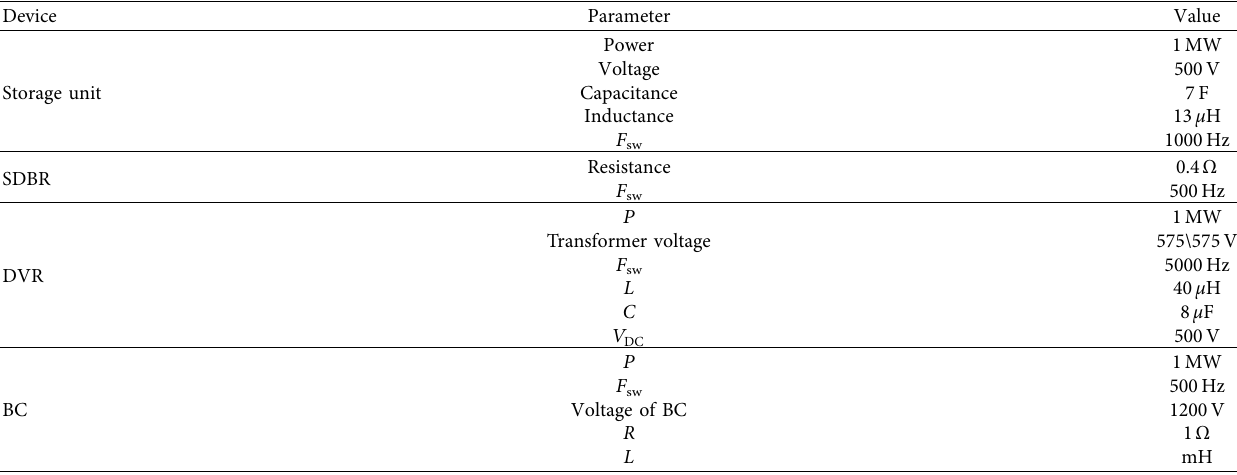
Table 9: Simulated FRTC methods parameters